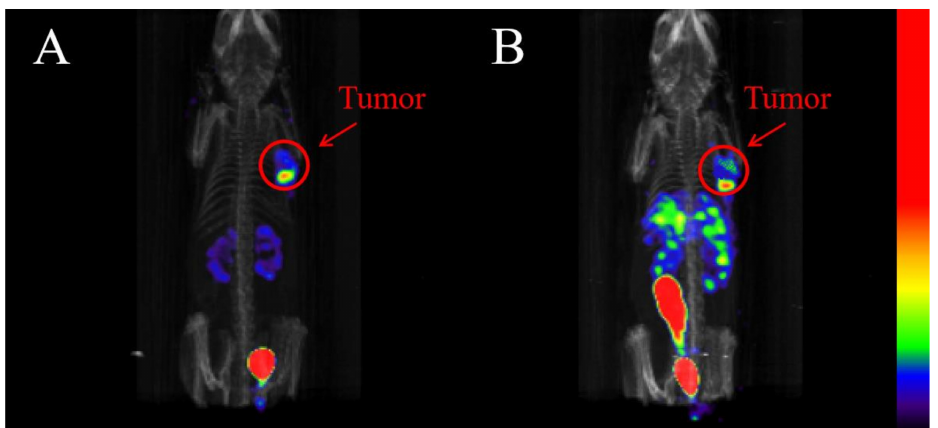
Figure 5. Whole-body SPECT/CT images of [ 99m Tc]Tc-CNMCHDG ( A ) and [ 99m Tc]Tc-CN7DG ( B ) in the same A549 tumor-bearing mouse at 2 h post-injection.